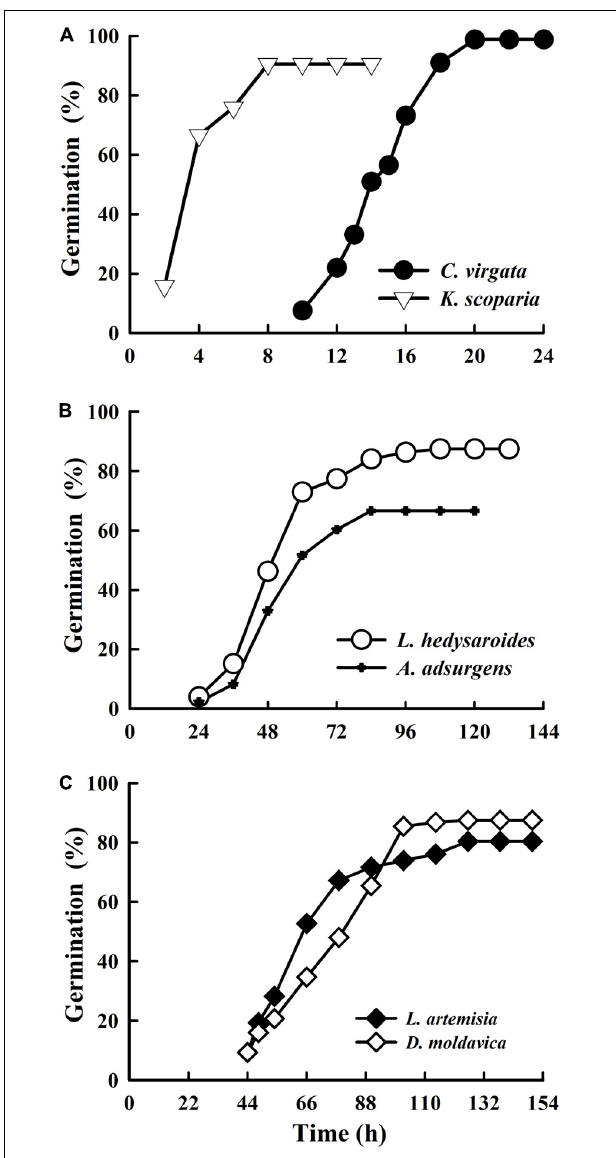
FIGURE 2 | Cumulative seed germination percentages of Chloris virgata , Kochia scoparia (A) , Lespedeza hedysaroides , Astragalus adsurgens (B) , Leonurus artemisia and Dracocephalum moldavica (C) seeds in light at 25 ◦ C.